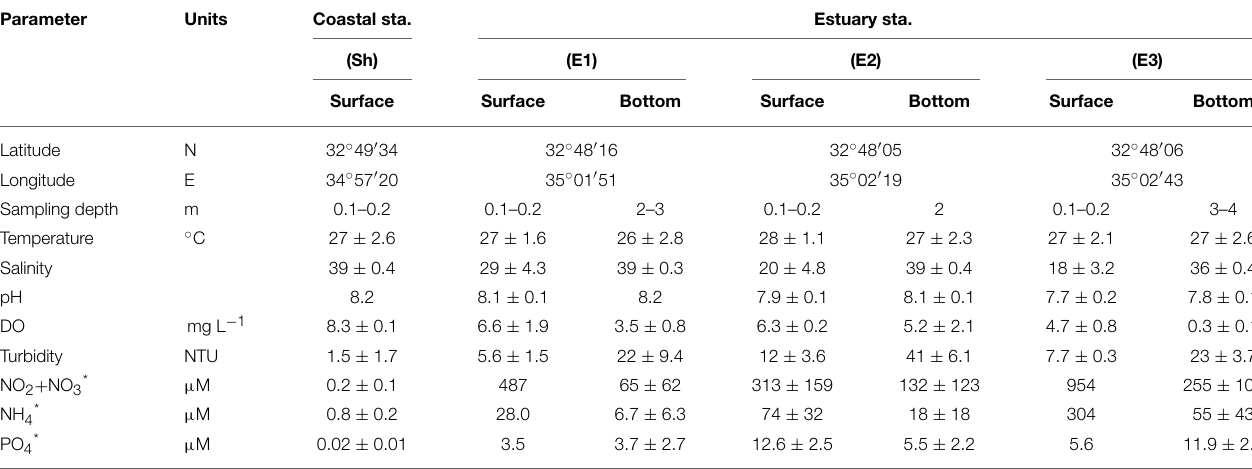
Values are the averages and their standard deviation represents four sampling dates. * Dissolved inorganic nitrogen and phosphorus were referred as DIN and DIP in the text respectively.